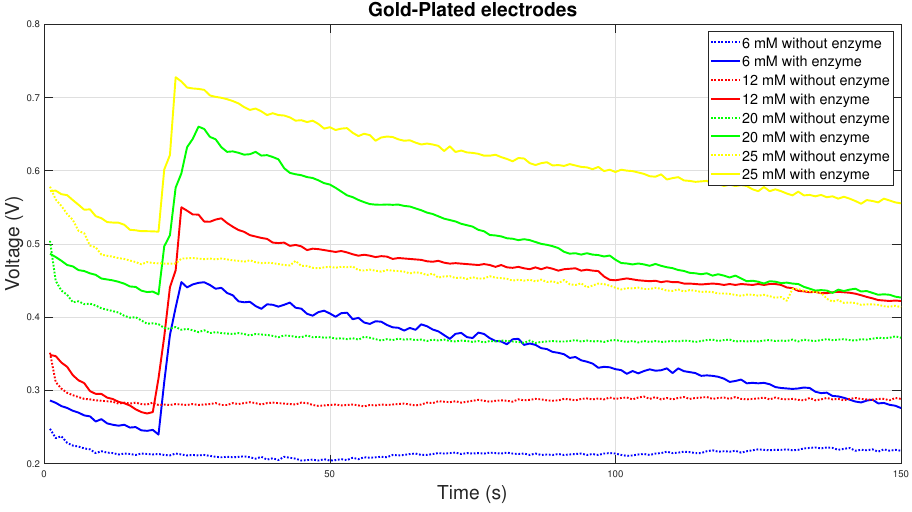
Figure 9. Voltage comparison between Cu electrodes.